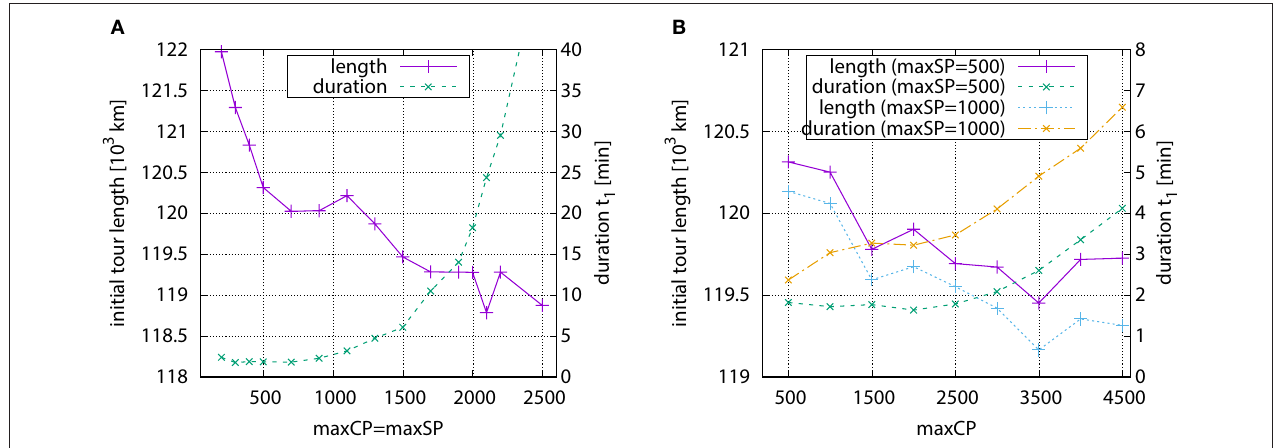
FIGURE 5 | Computation times in minutes for building an initial tour and resulting tour length dependent on chosen values of maxCP and maxSP : (A) equal values maxCP maxSP ; (B) fixed value for maxSP . =